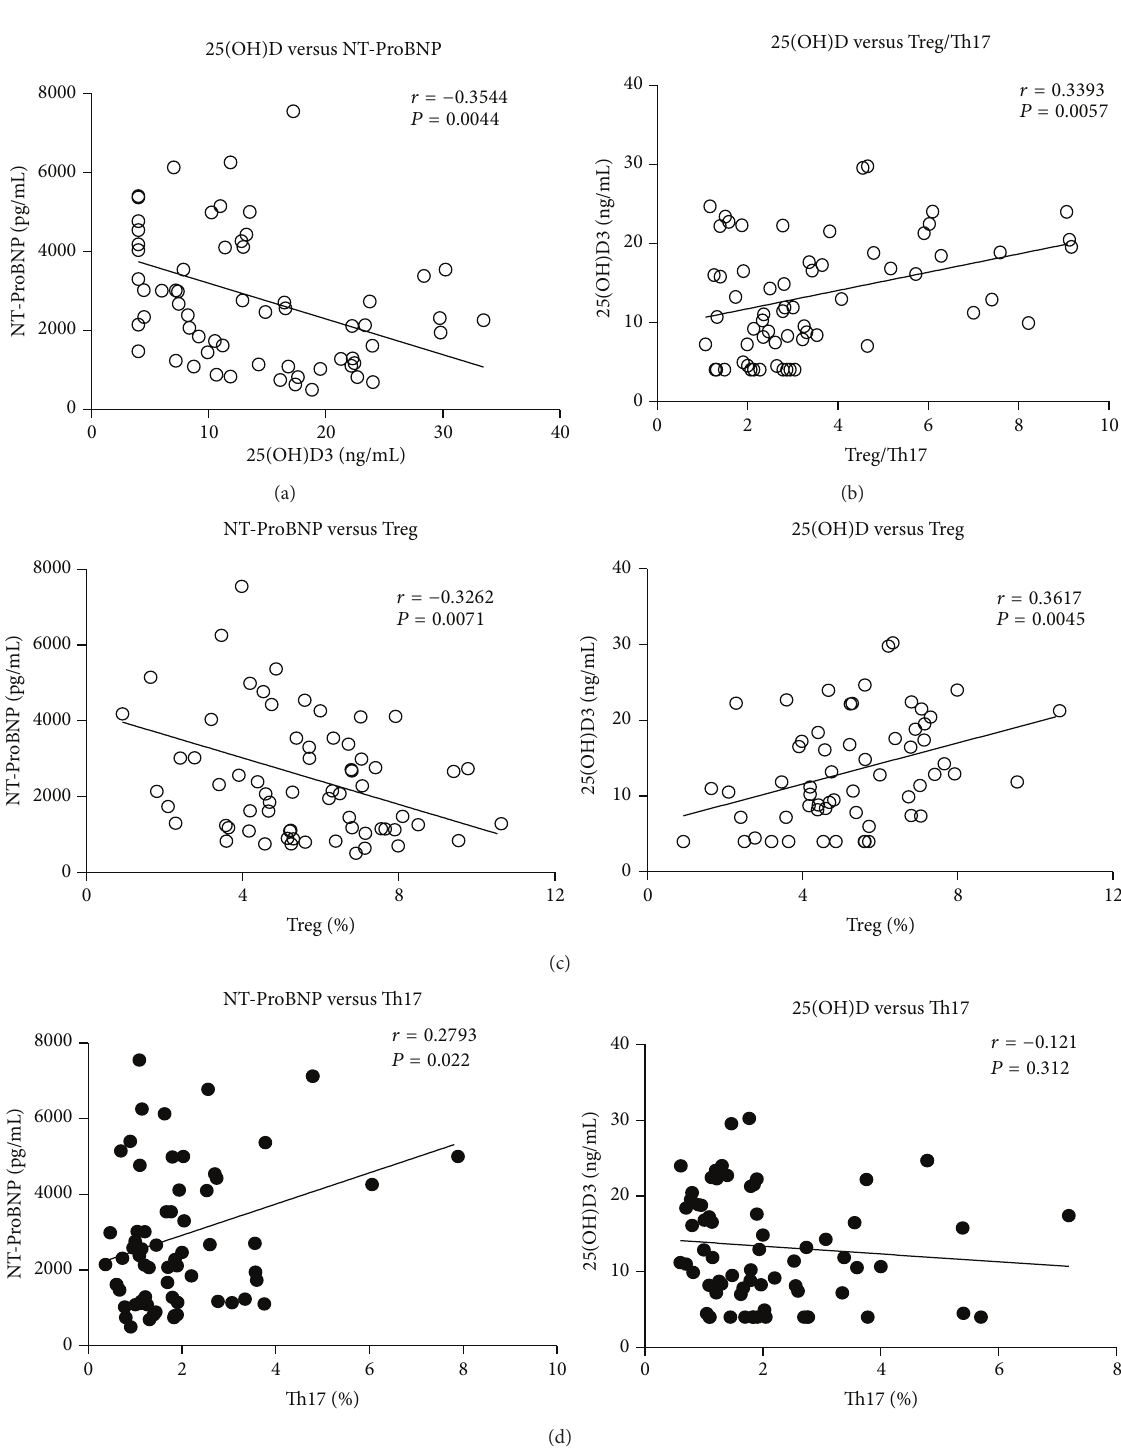
Figure 2: The correlation between Treg or Th17 and 25(OH)D or NT-ProBNP in chronic HF. (a) 25(OH)D was correlated with Treg/Th17 and NT-ProBNP. (b) The significant decreased frequency of Treg in patients with chronic HF positively correlated with 25(OH)D and negatively correlated with NT-ProBNP. (c) The frequency of Th17 positively correlated with NT-ProBNP but not correlated with